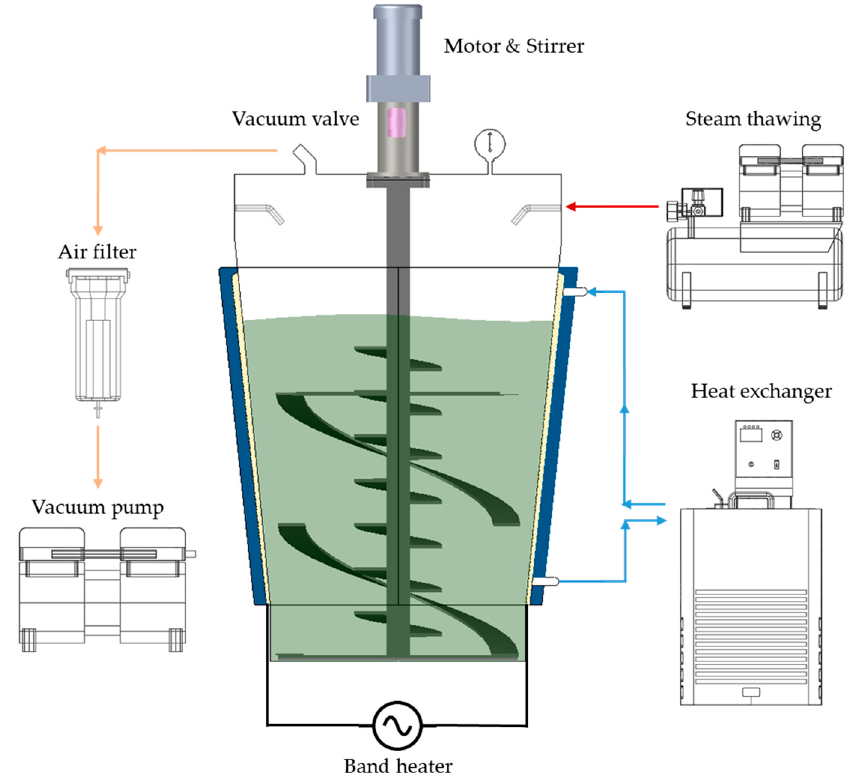
Figure 5. A schematic diagram of the vacuum-steam combination heating system.